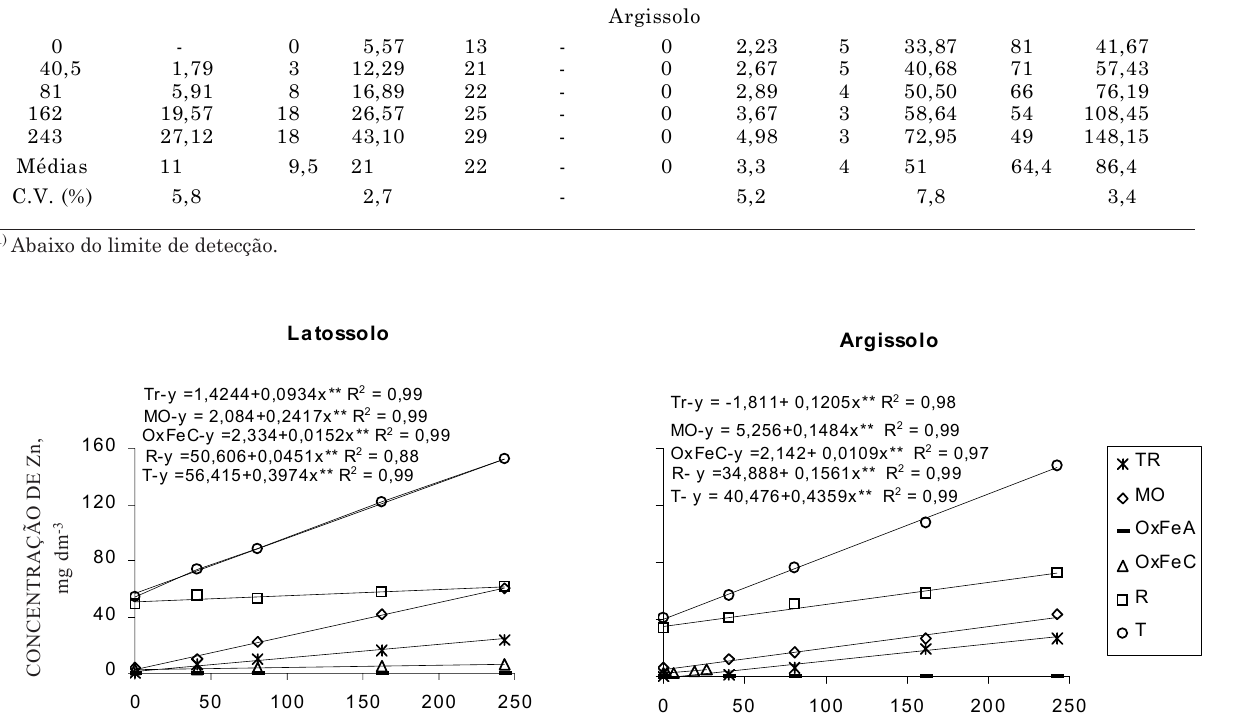
Figura 2. Efeito de doses na distribuição de Zn em frações de solos incubados com lodo de esgoto.